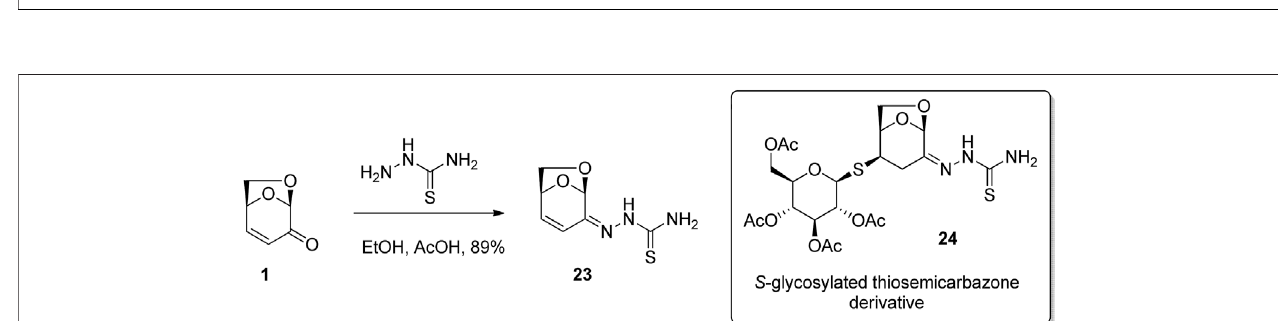
FIGURE 7 | Preparation of phencyclidine analogues using LGO.